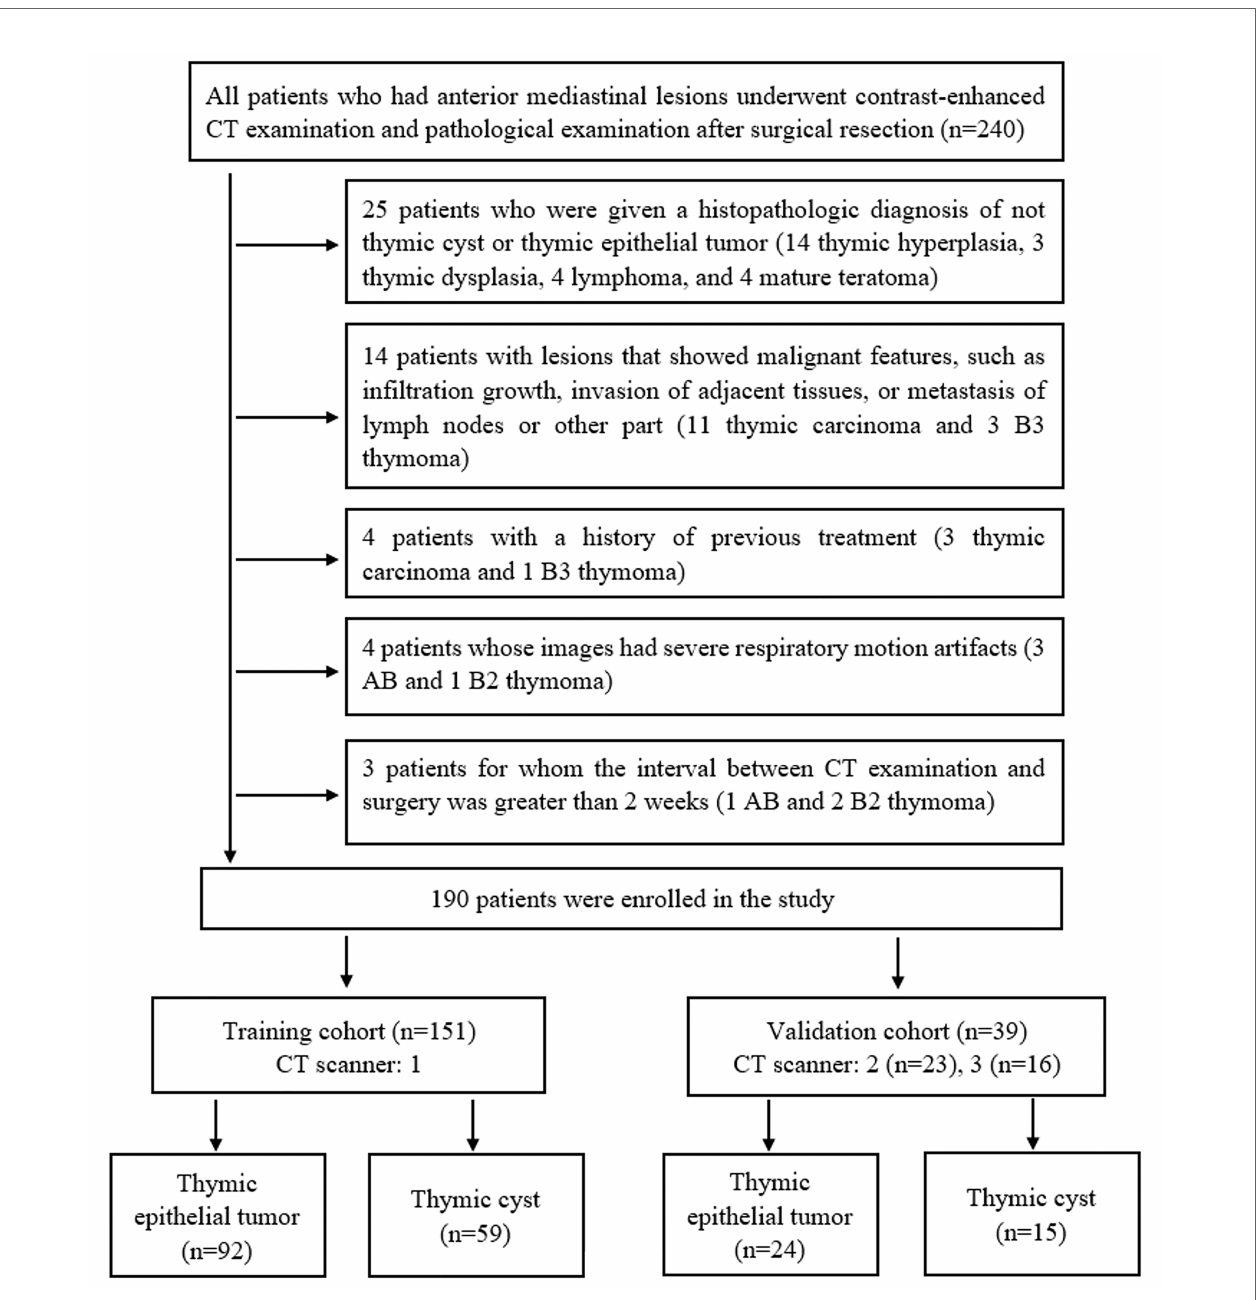
FIGURE 1 | Flow chart of patients ’